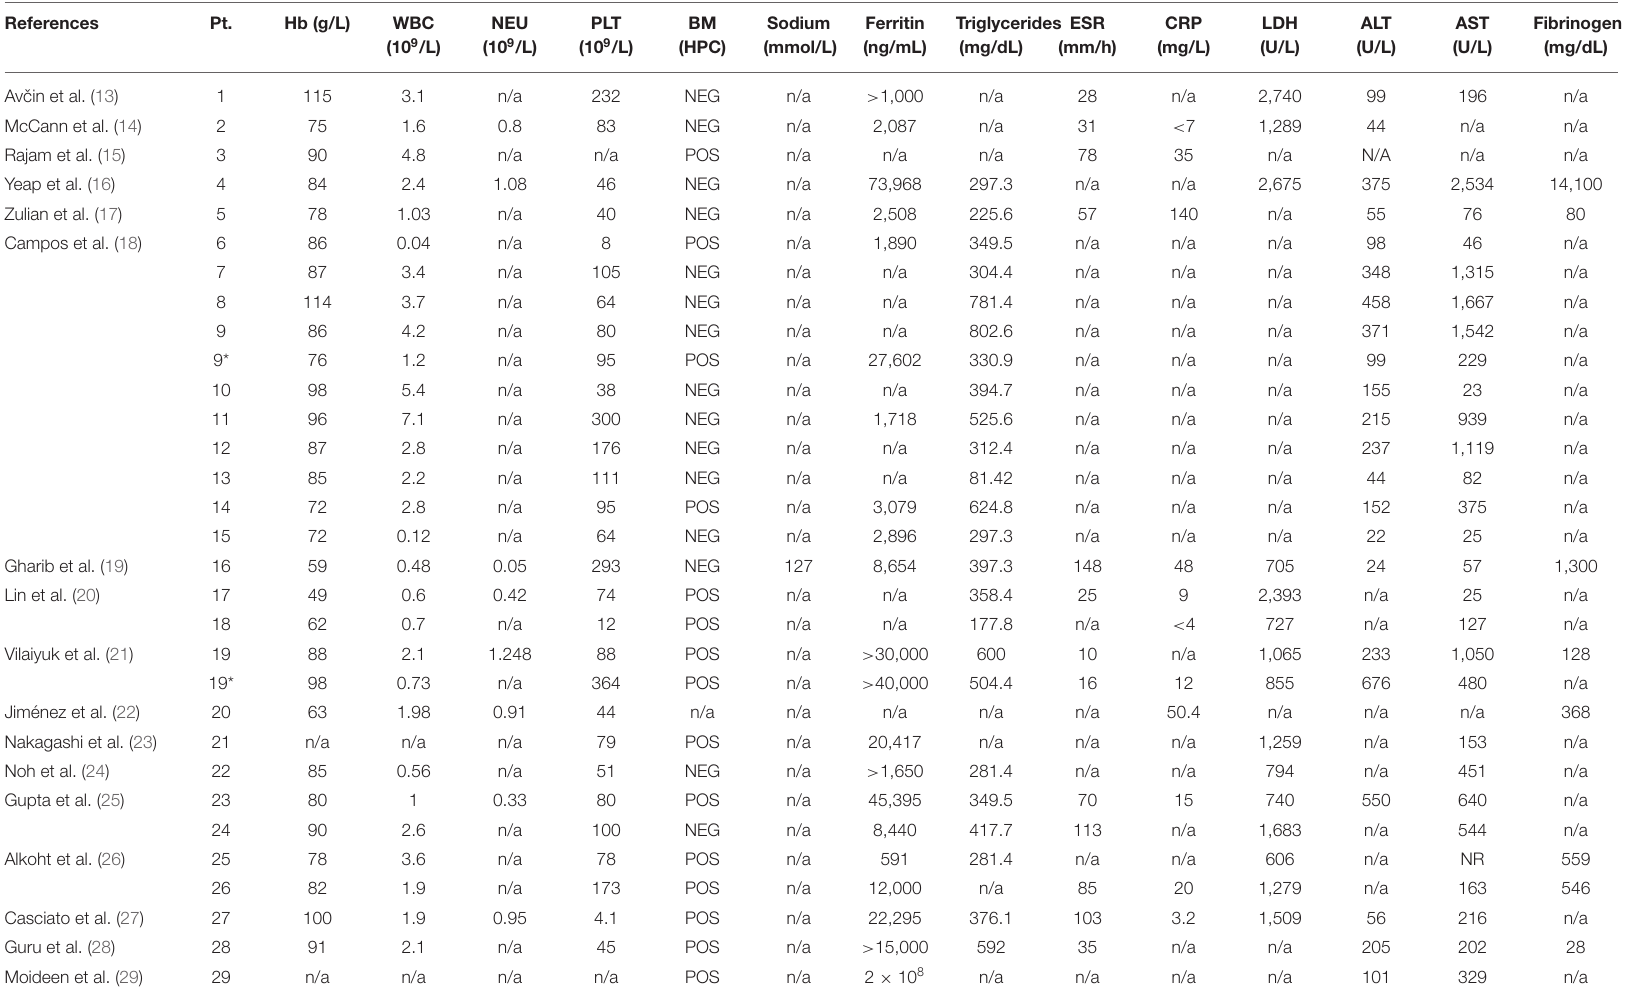
TABLE 2 | Laboratory values of patients with pediatric Systemic Lupus Erythematosus (pSLE) and Macrophage Activation Syndrome (MAS) described in case